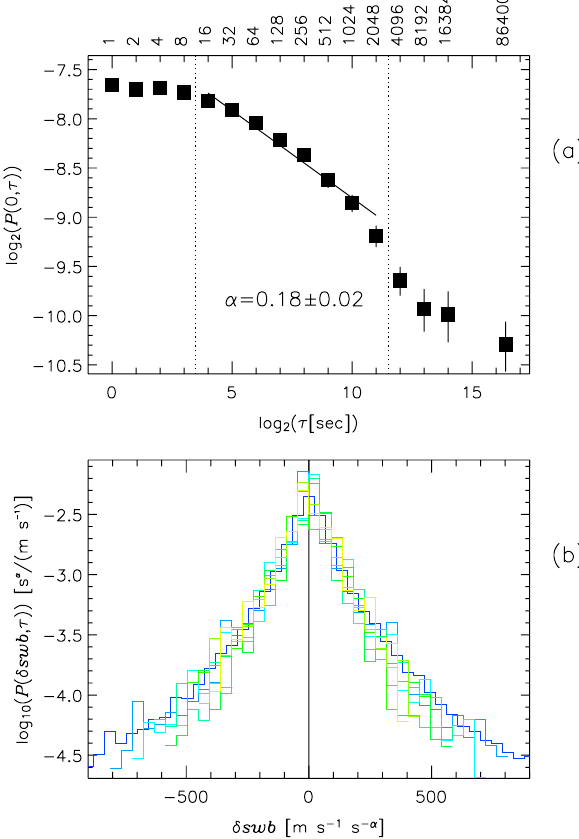
Fig. 8. (a) Scaling of the PDF peaks, log 2 P (0, τ ) versus log 2 τ for the δ swb curves shown in Fig. 7. The vertical dashed lines indicate nominal inner and outer temporal scales for the power law regime. The linear best fit to this regime yields a slope of α 0 =0.18 ± 0.02 using a PDF bin size of 45km. The error bars assume Gaussian noise in the peaks, and are drawn at the 3 σ level. (b) Scaling col- lapse of the PDFs for τ =16s to 2048s and δ swb < 900km shown in Fig. 7. The scaling exponent α 0 =0.18 was used, but better collapse was achieved using smaller values of α 0 .